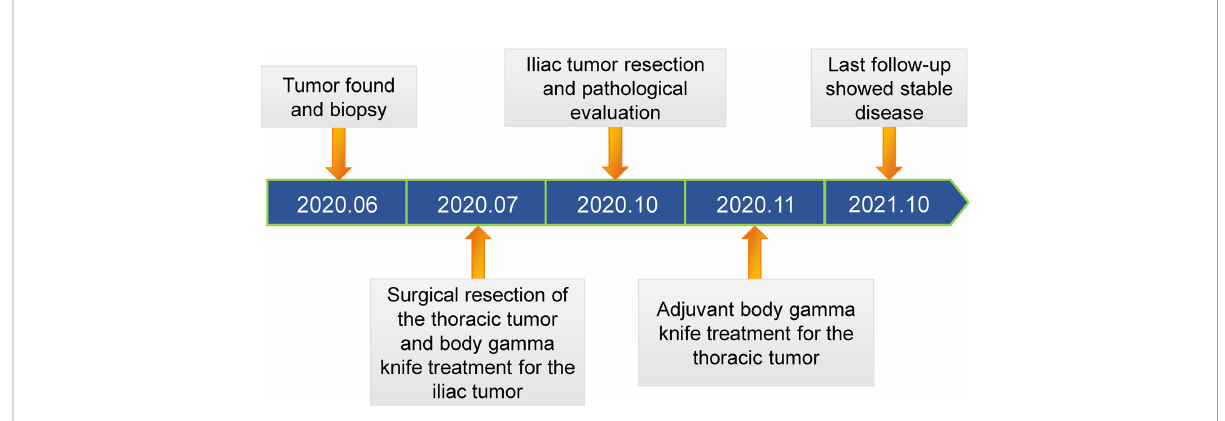
FIGURE 4 Timeline of the occurrence of major clinical events during the treatment and